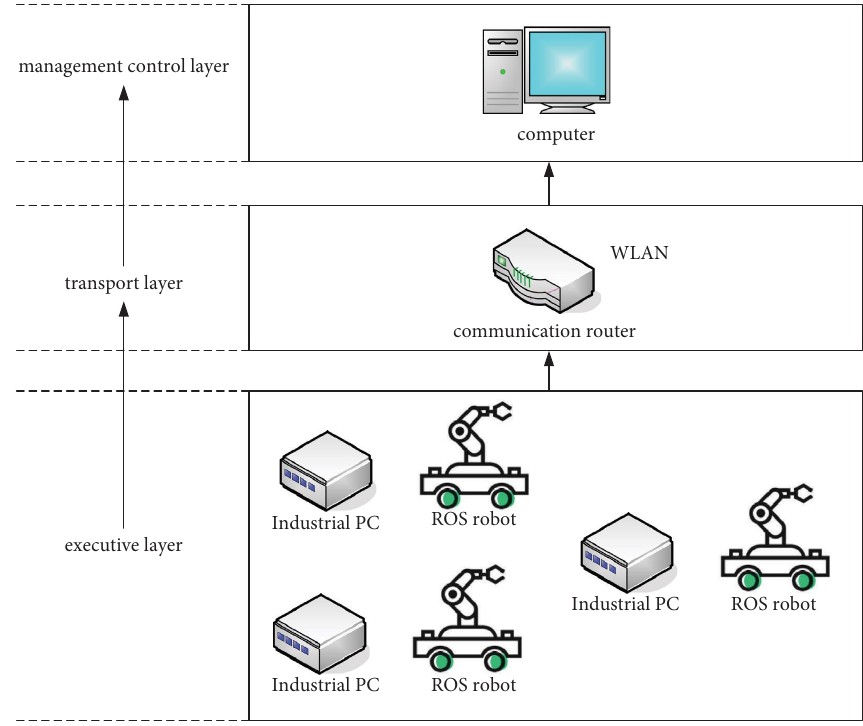
Figure 1: Framework of intelligent logistics management